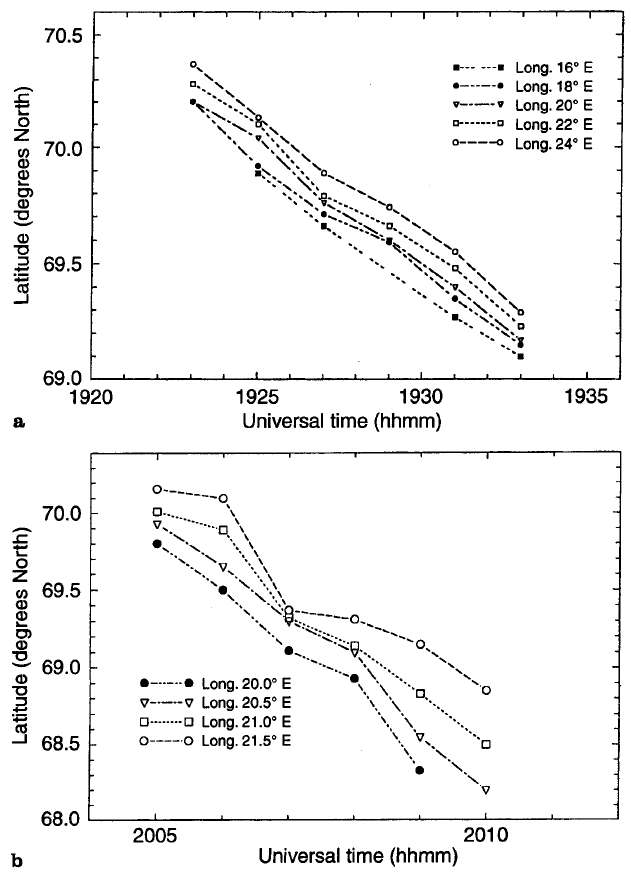
Fig. 2a,b Drift of an auroral arc in latitude along di(cid:128)erent circles of longitude as observed at Kilpisja¨ rvi a on 1 March 1995 between 1923 and 1933 UT, b on 28 October 1992 between 2005 and